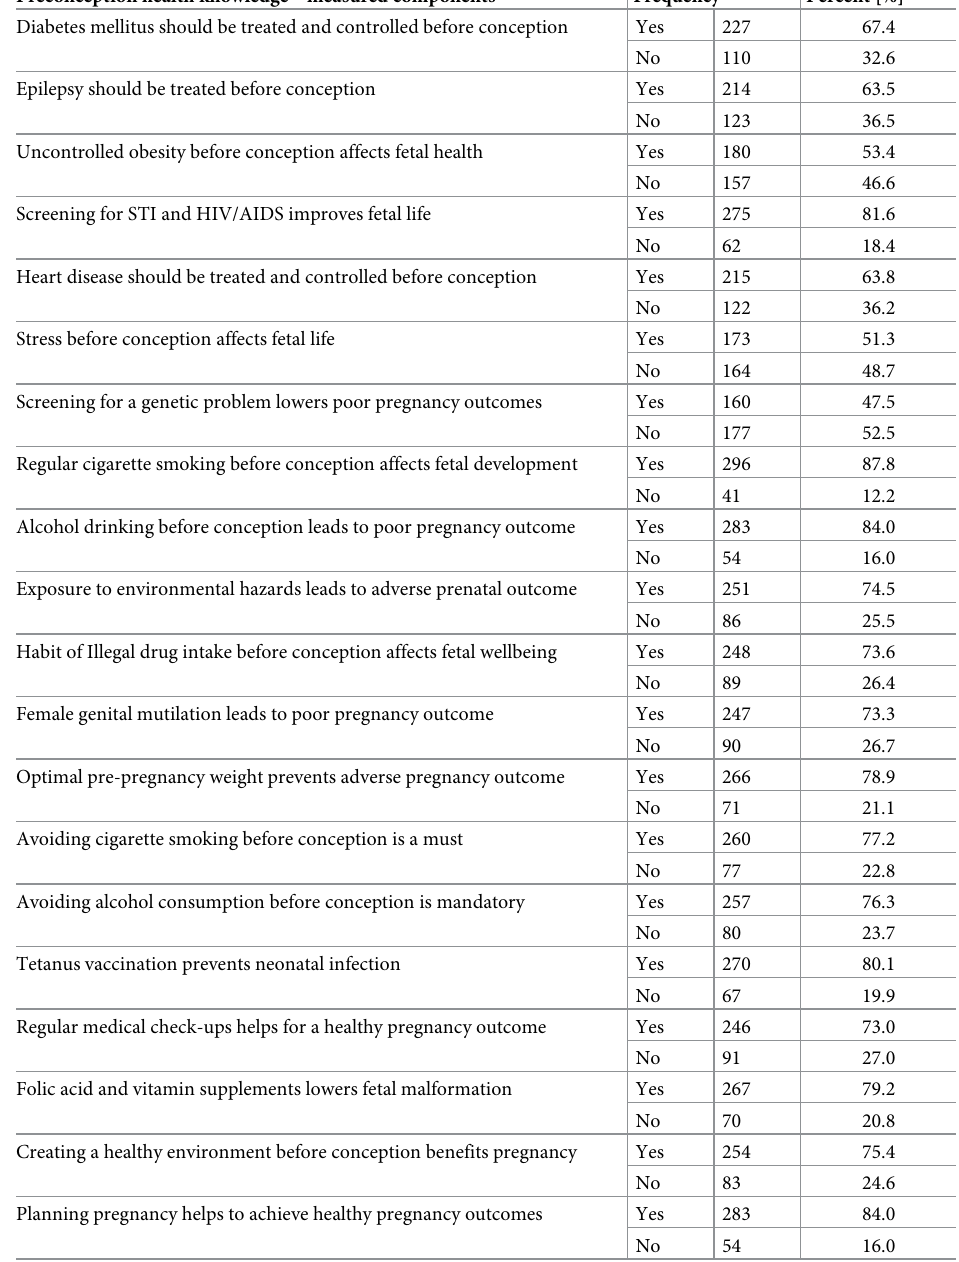
Table 3. Women’s knowledge on preconception health care components in Jinka town, Southern Ethiopia, 2018 [n = 337]. Preconception health knowledge—measured